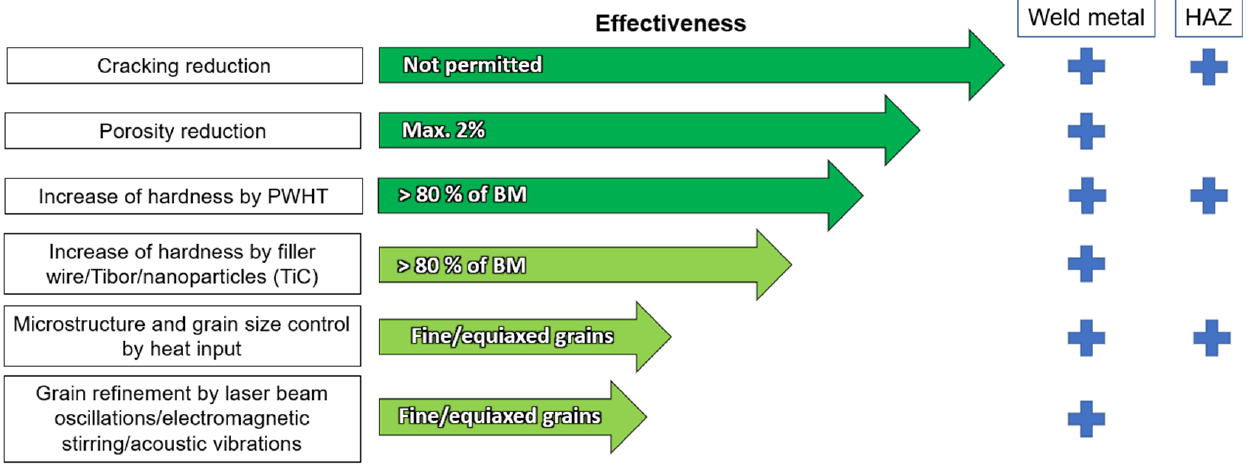
Figure 24. Strategy to increase mechanical properties for welding of Al alloys. Note, ranking is based on effectiveness, costs, and practical use for industry.